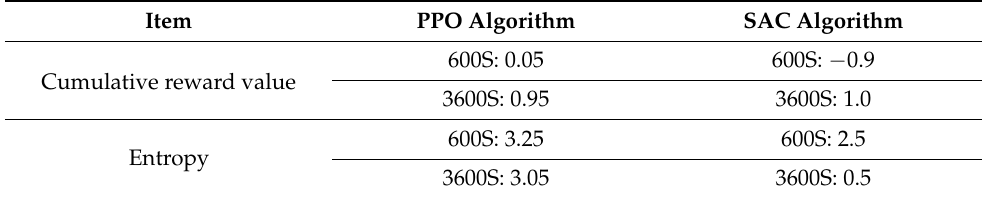
Table 5. Results of machine learning with PPO and SAC